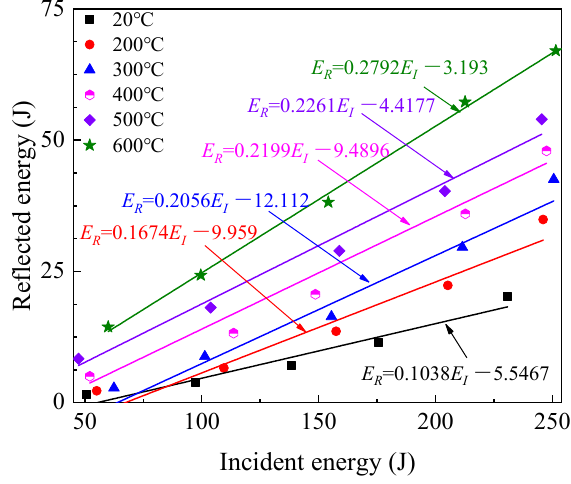
Figure 12. Relationship between reflected and incident energy.